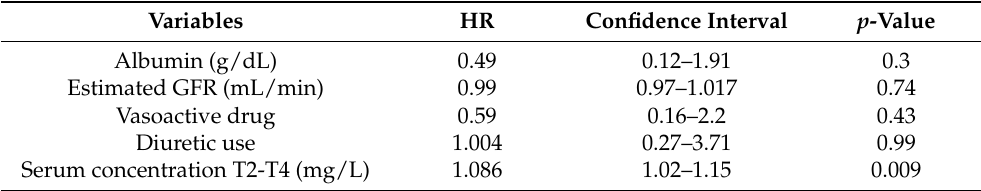
Table 3. Cox regression of the associated variables with AKI in patients using vancomycin admitted to the